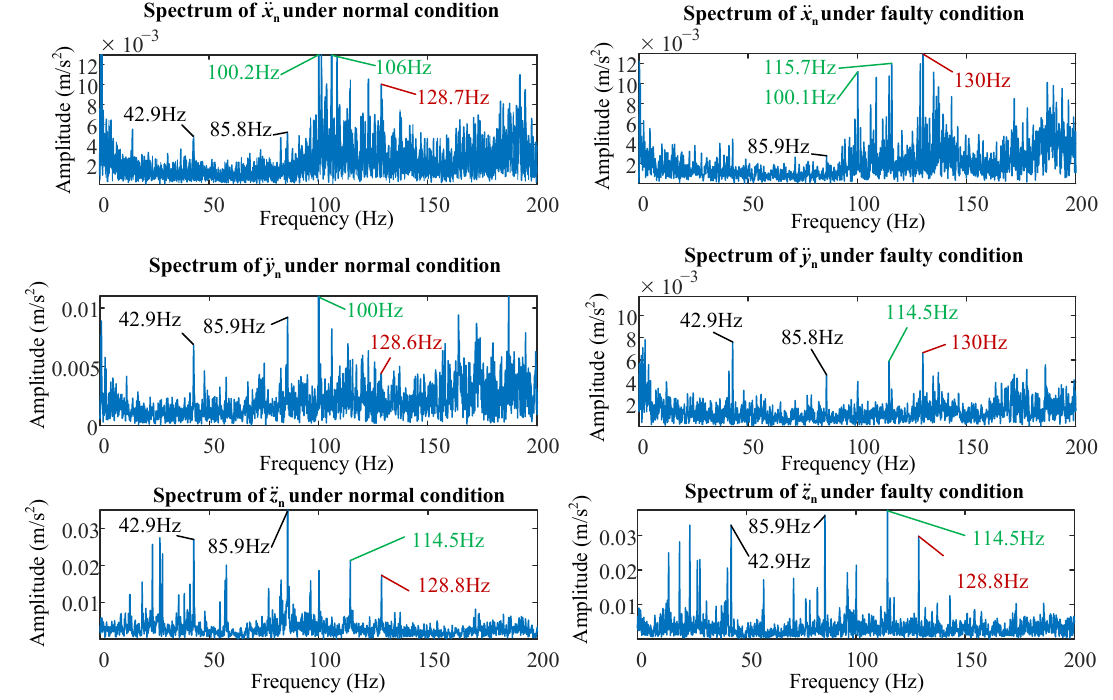
Figure 18. Experimental acceleration spectra of the nut-related parameters under normal and faulty conditions (the acceleration values are calculated from the voltage values, which are directly measured by the accelerometers).